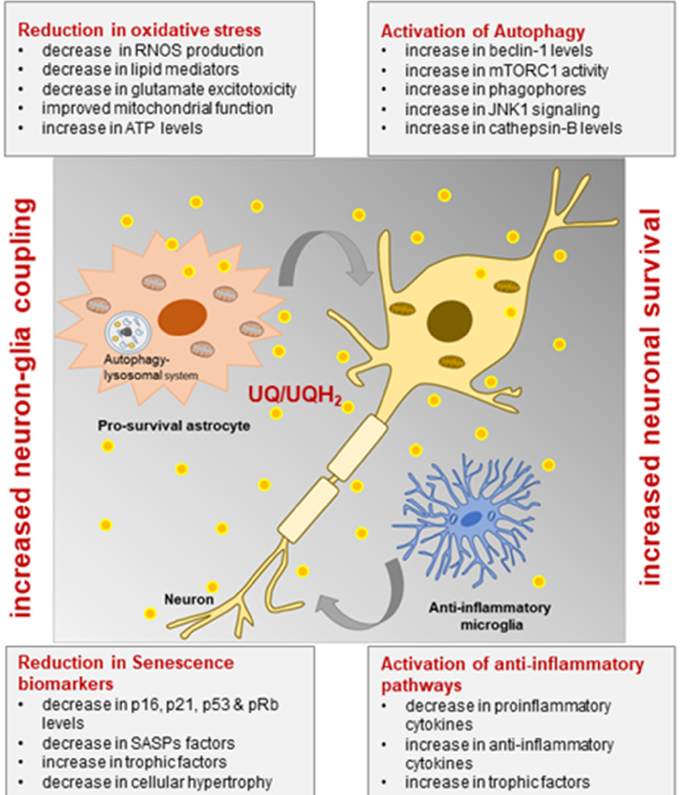
Figure 4. Schematic illustrating the neuroprotective potential of Ubisol-Q 10 . Ubiquinone (UQ) is converted to Ubiquinol (UQH2), which is involved in key cellular functions. Neuroprotection could be mediated through modulation of several astrocytic and microglial pathways, for instance reduc- tion of oxidative stress by decreasing reactive oxygen and nitrogen species (RNOS), lipid mediators, glutamate excitotoxicity and improving mitochondrial function. Activation of autophagy by increas- ing beclin-1 levels and up-regulating mTORC1, JNK and cathepsin-B activity. Decreasing cellular senescence by reducing growth arrest and secretion of pro-inflammatory mediators and increas- ing secretion of neurotrophic growth factors. Increasing anti-inflammatory effects by decreasing inflammatory mediators such as IL-6, TNF- α and IL-1 β . These effects result in restoring cellular homeostasis, leading to increased neuron-glia coupling and neuronal